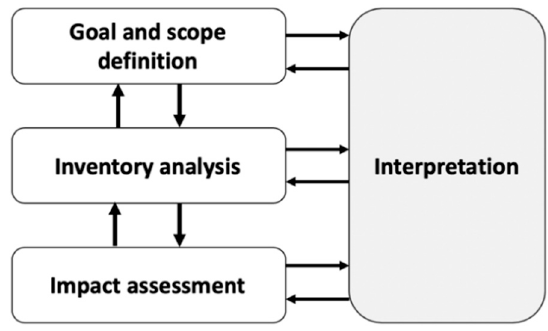
Figure 1. Life cycle assessment.